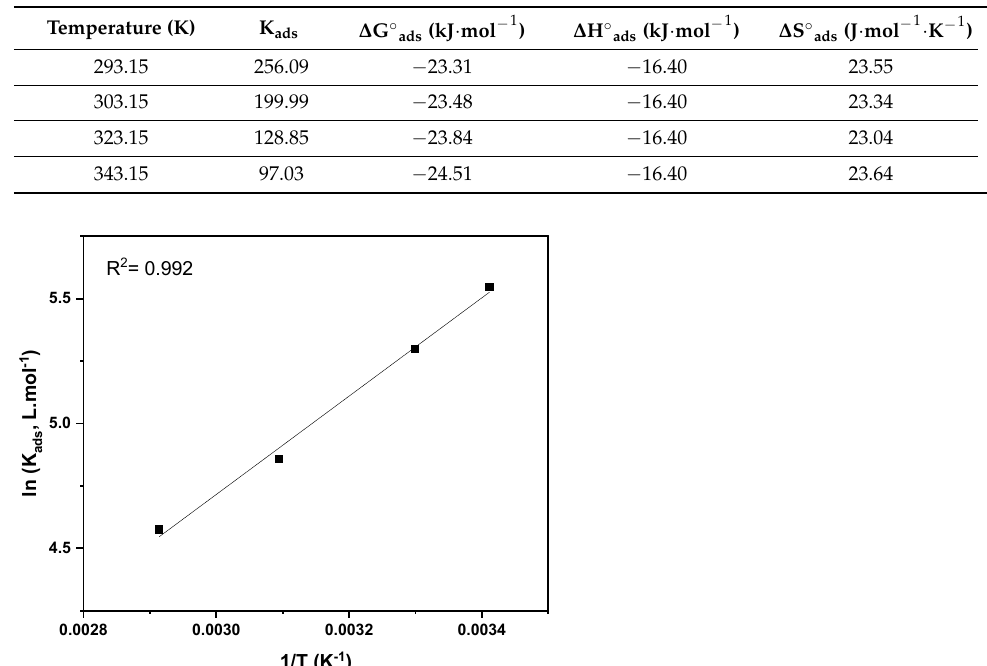
Table 4. Thermodynamic parameters calculated from Freundlich isotherm fitting, as shown in Figures 6 and 7.